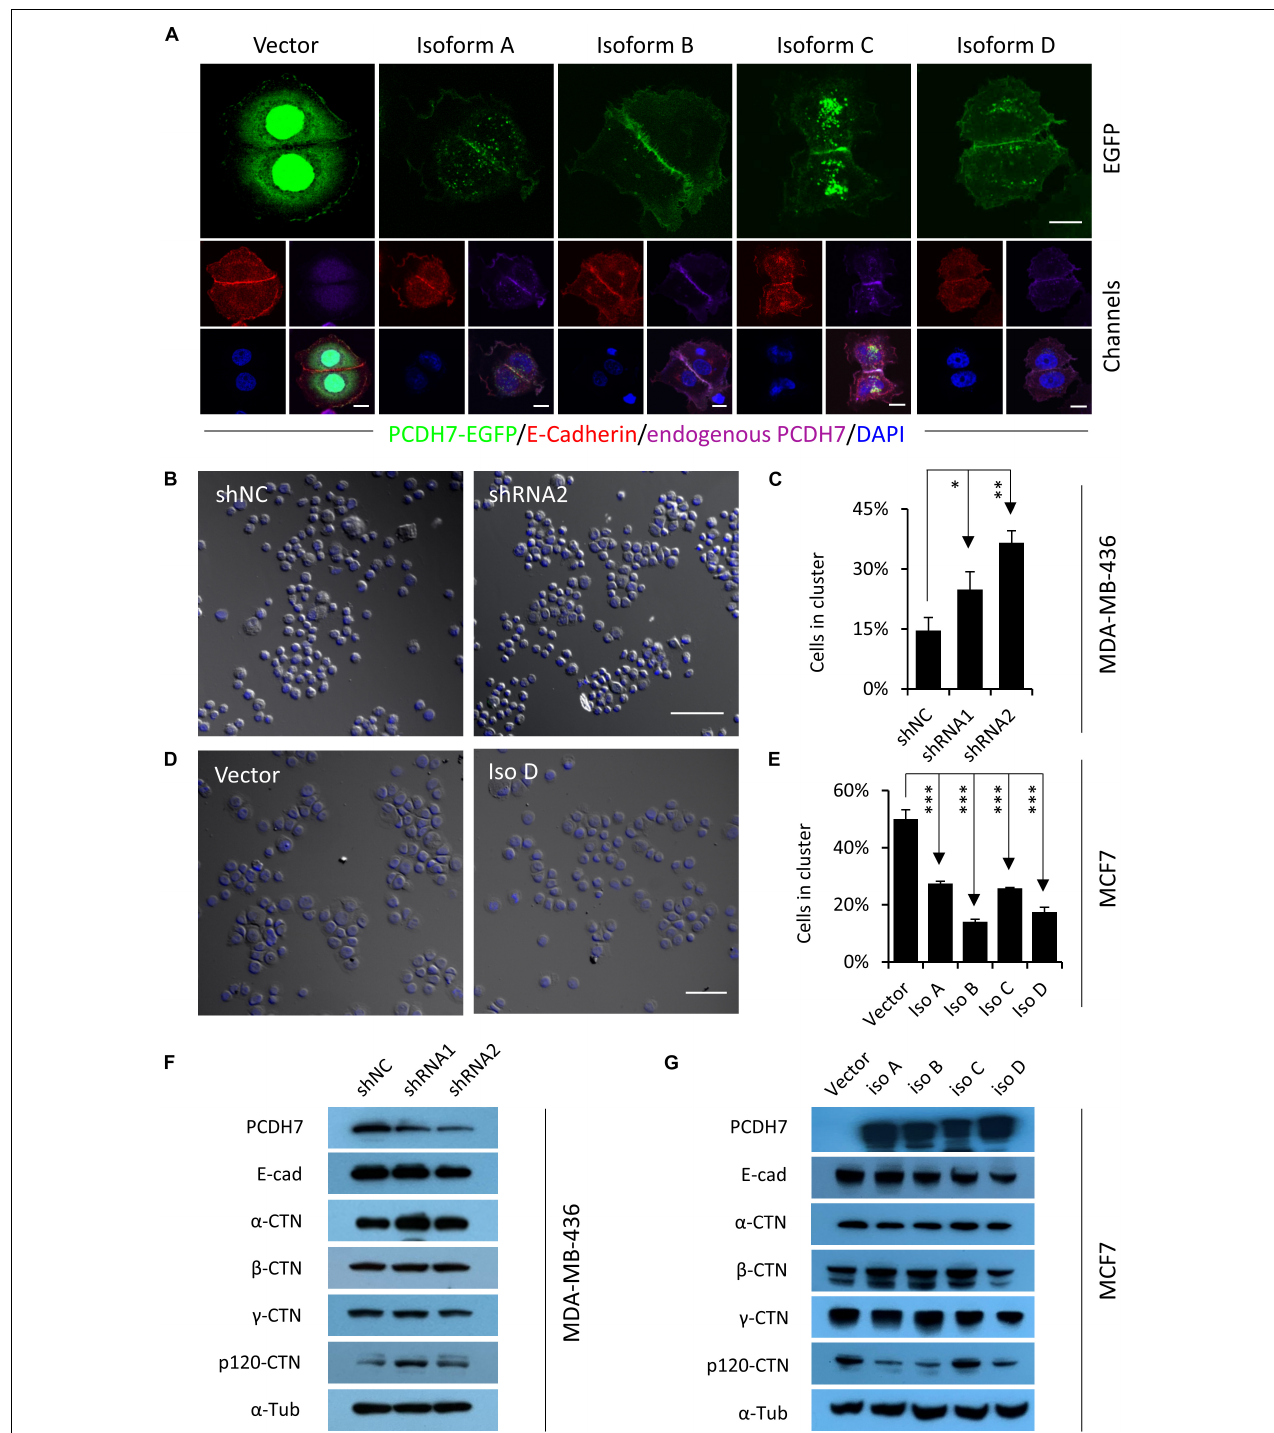
FIGURE 2 | PCDH7 inhibits intercellular adhesion. (A) Subcellular localization of PCDH7 isoforms in MCF7 cells. Cells expressing EGFP-tagged PCDH7 isoforms (green) were stained with anti-E-cadherin (red) and anti-PCDH7 (purple) antibodies. Scale bars: 10 µ m. (B) Representative images for cluster formation of PCDH7 -depleted MDA-MB-436 cells. The nuclei were stained with DAPI. Scale bar: 100 µ m. (C) Quantification of cells forming clusters in PCDH7 -depleted MDA-MB-436 cells. Data are mean ± SD of triplicate experiments. ∗ P < 0.05; ∗∗ P < 0.01. (D) Representative images for cluster formation of MCF7 cells overexpressing PCDH7D. The nuclei were stained with DAPI. Scale bar: 100 µ m. (E) Quantification of cells forming clusters in MCF7 cells overexpressing PCDH7 . Data are mean ± SD of triplicate experiments. ∗∗∗ P < 0.001. (F,G) Expression of adhesion molecules upon PCDH7 depletion (F) or overexpression (G) as detected by Western